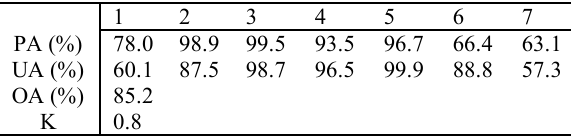
Table 5.2. Results obtained for 2018-year classification. PA: Producers Accuracy; UA: User’s Accuracy; OA: Total precision and Kappa classification.